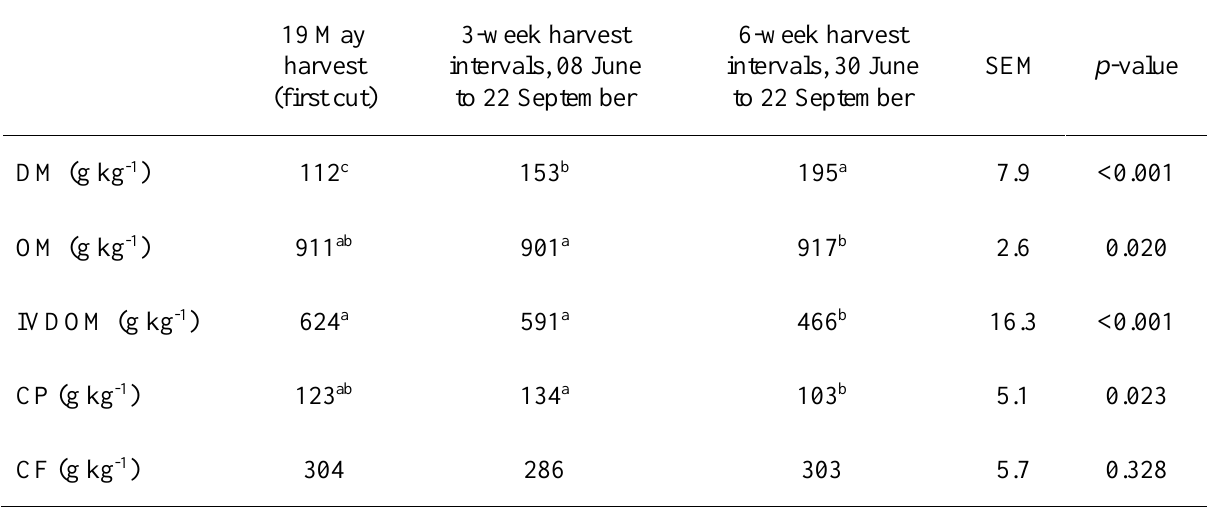
Table 6. Experiment III: Dry matter (DM) yield, and dry matter contents of organic matter (OM), in vitro digestible organic matter (IVDOM), crude protein (CP) and crude fibre (CF) for the May harvest (Experiment II) and average contents of harvested biomass from the 3-weekly (6 cuts) and 6-weekly (3 cuts) subsequent harvests. SEM = standard error of the